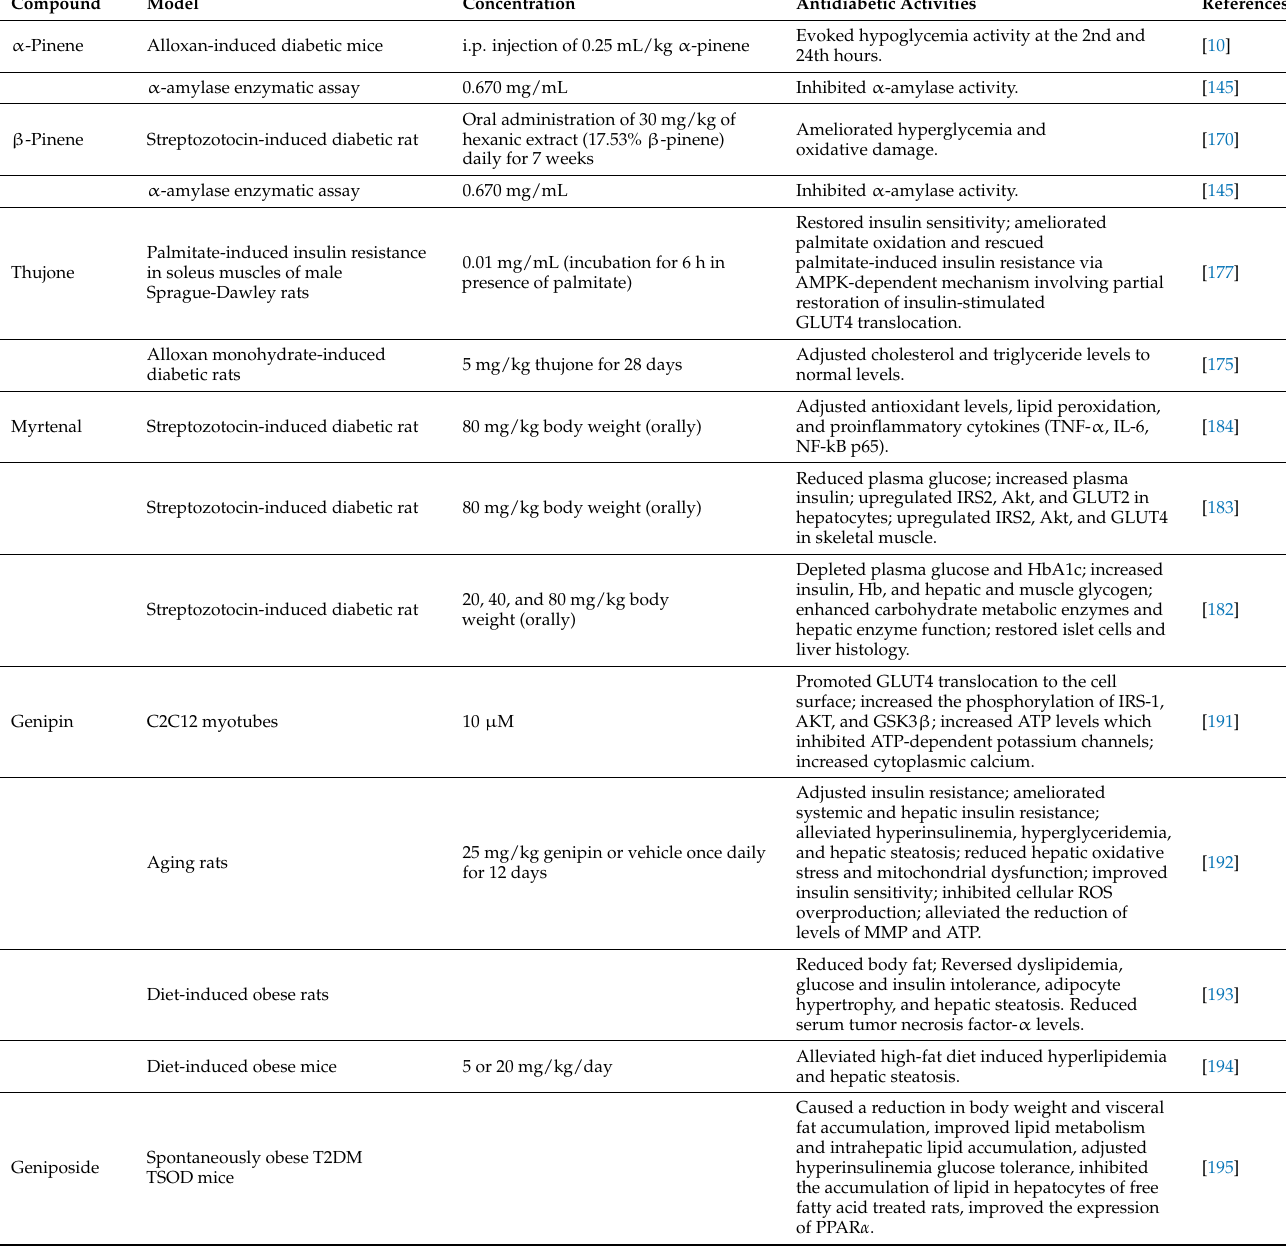
Table 3. Antidiabetic effects of bicyclic